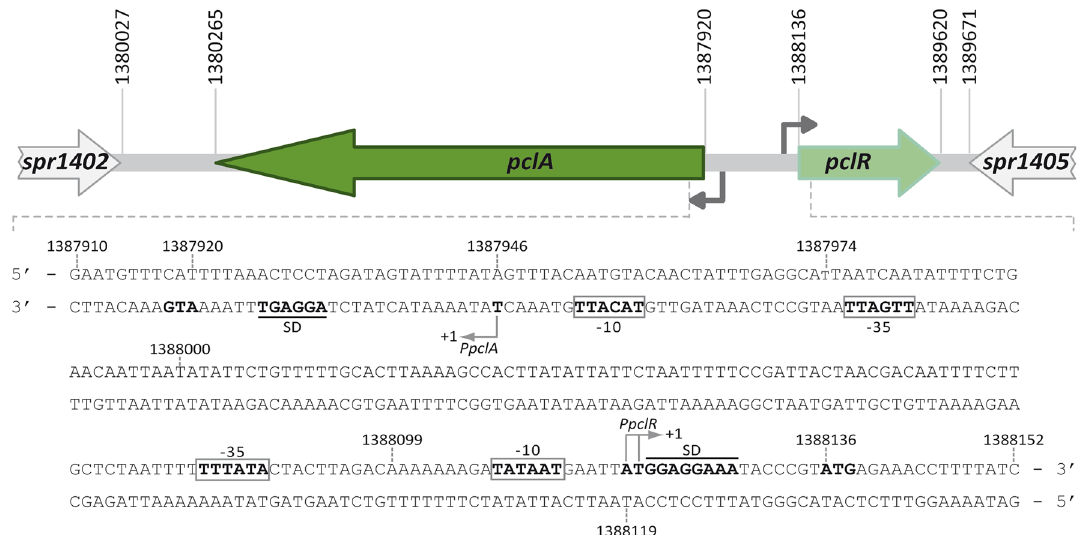
Figure 1. The R6-specific pclA - pclR cluster. Gene spr1404 has been named pclR in this work. For each gene, the coordinates of the translation start and stop codons are indicated. Arrows upstream of the genes represent promoters. The nucleotide sequence of the region spanning coordinates 1,387,910 to 1,388,152 of the S. pneumoniae R6 chromosome is shown. The main sequence elements (− 35 box and − 10 box) of the promoters identified in this work ( PpclA and PpclR ) and the transcription start sites (+1 position) are indicated. The putative Shine-Dalgarno sequence (SD) and the translation start codon (ATG) of the pclA and pclR genes are indicated in boldface